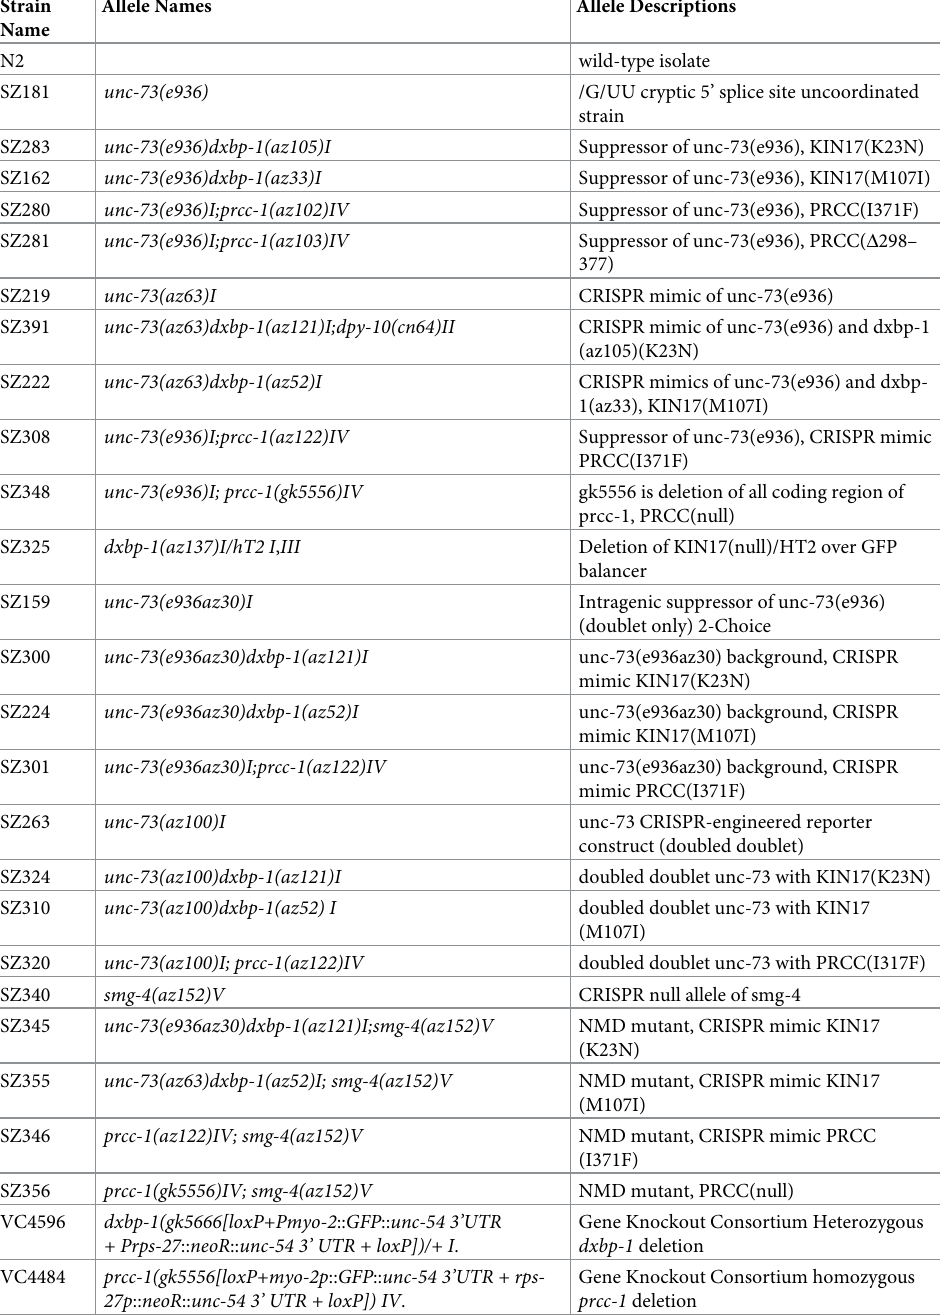
Table 2. Genotypes of C . elegans strains used in this